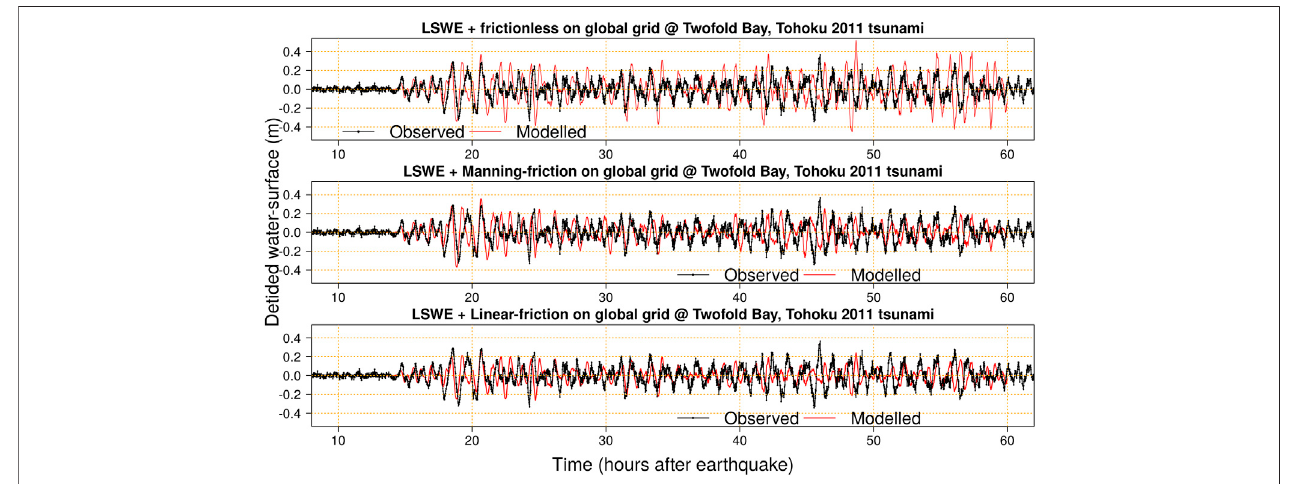
FIGURE9| Simulations and observations oftheTohoku 2011tsunami at Twofold Bay. Note the observed late-timemaxima 46 hpost-earthquake. Allsimulations usetheTohoku2011S13sourcemodel.Top:UsingthefrictionlessLSWEontheglobalgrid.Middle:UsingLSWEwithManning-frictionontheglobalgrid.Bottom:Using LSWE with linear-friction on the global